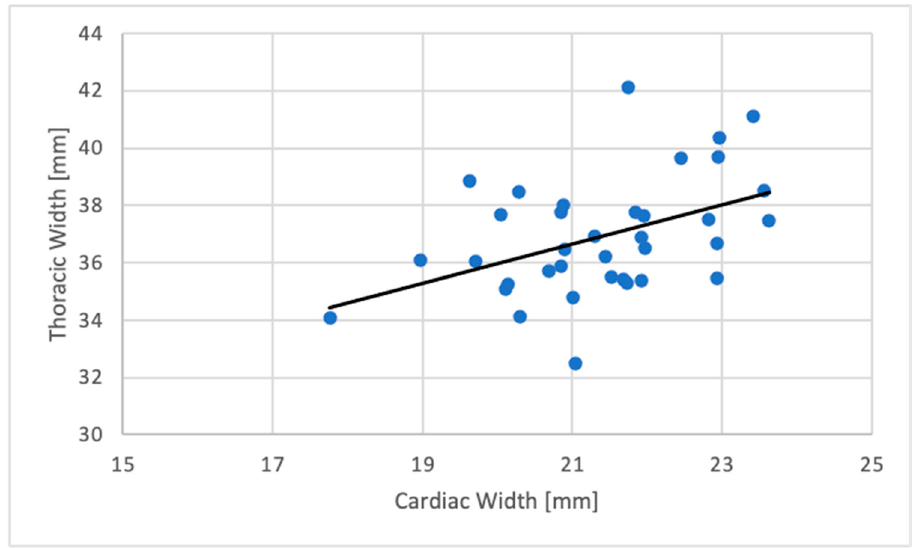
Figure 3. Scatterplot showing the relation between the cardiac width (mm) and the cranial coelom width (mm) in the VD radiographic projection ( N = 36).